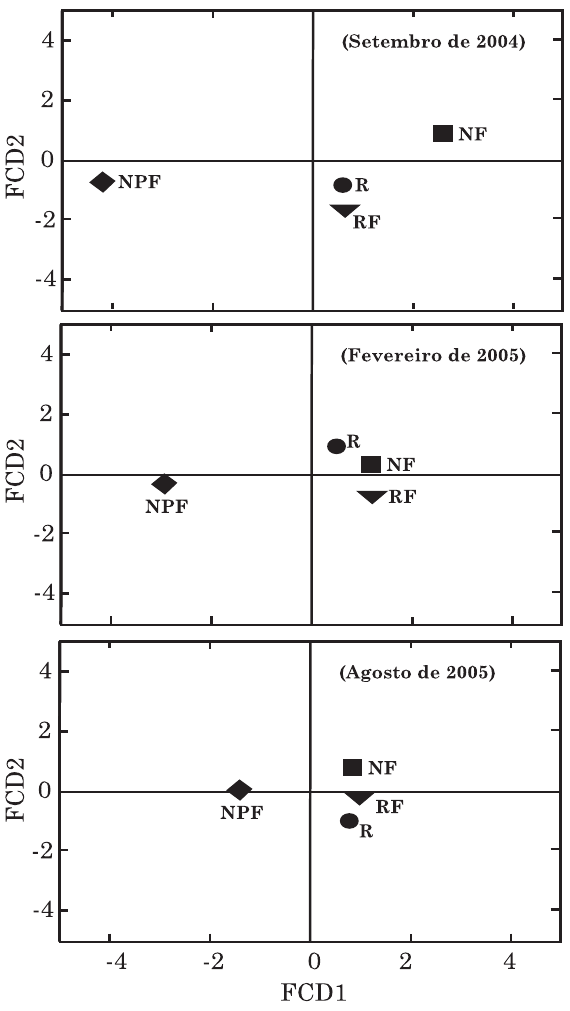
Figura 1. Relação entre a primeira e segunda função canônica discriminante (FCD e FCD ) sobre as 1 2 médias (centróides) dos coeficientes canônicos padronizados (CCP) referentes aos atributos carbono da biomassa microbiana (CBM), respiração basal (C-CO ), quociente metabólico 2 ( q CO ) e carbono orgânico total (COT) do solo, 2 discriminando as Florestas de Araucária natural (NF), introduzida (R), introduzida impactada (RF) e área de pastagem natural com araucárias nativas impactadas pela queima acidental (NPF), em setembro de 2004, fevereiro de 2005 e agosto de 2005